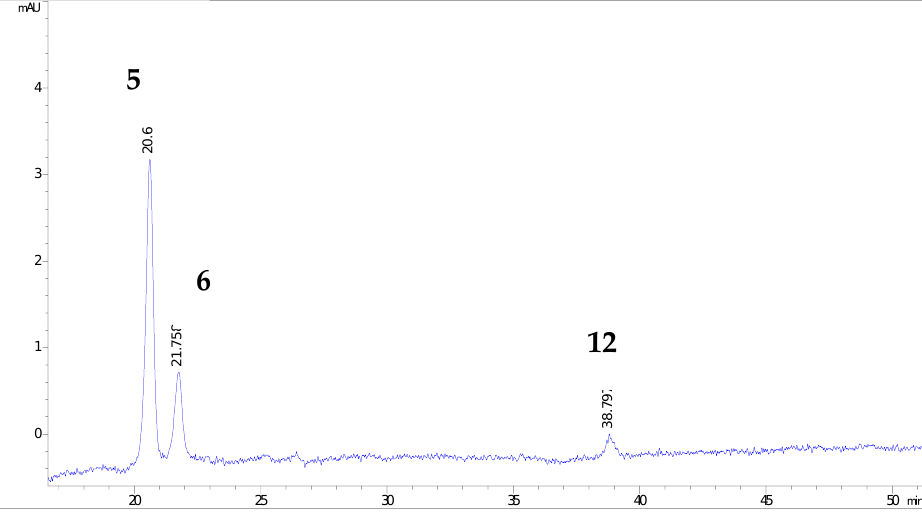
Figure 4. HPLC chromatograms of investigated black mulberry juice and flavonoid compounds identified (the numbers refer to corresponding peaks, presented in Table 1): hyperoside (5), isoquercetin (6) and quercetin (12).